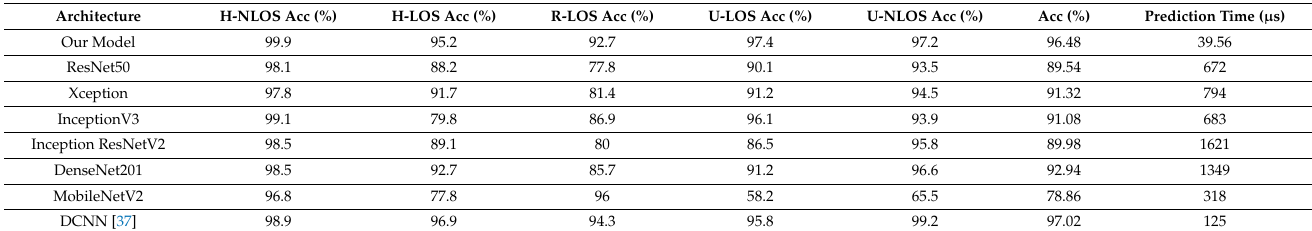
Table 7. Comparison between our model and state-of-the-art